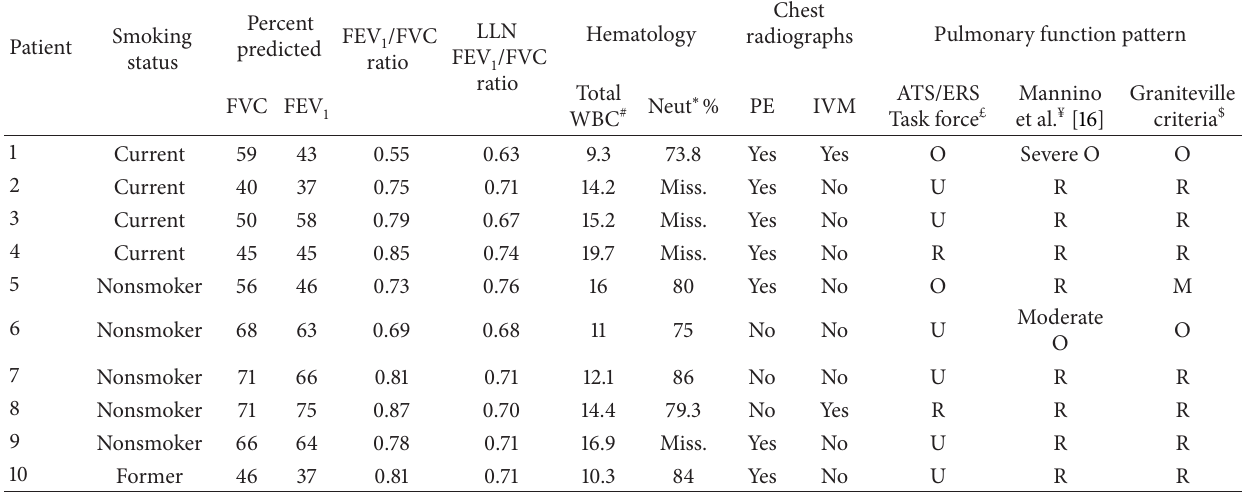
Table 5: Pulmonary function pattern and radiographic findings in patients who underwent